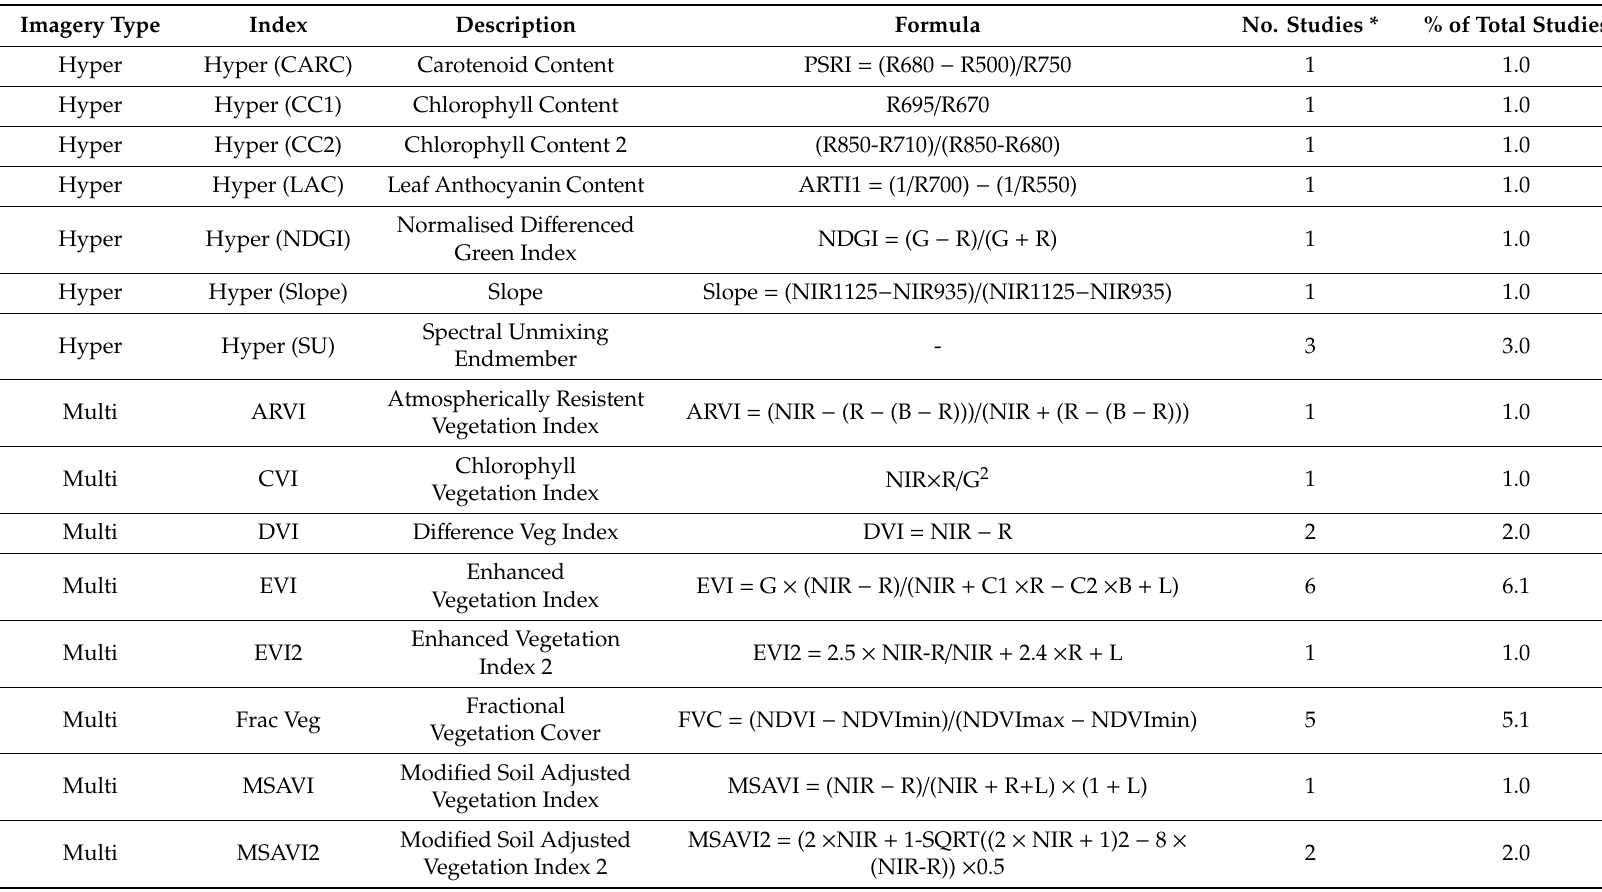
Table A1. Summary of indices used in the review. Hyper = Hyperspectral, Multi = Multispectral, SAR = Synthetic Aperture Radar, VIS = Visible. * Note that many studies used multiple